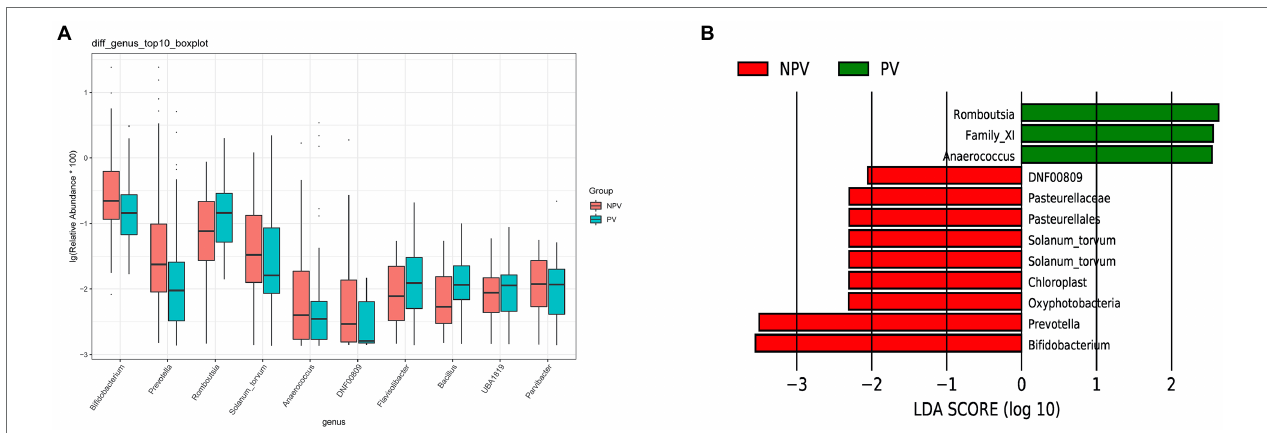
FIGURE 6 | Differences in the vaginal microbiota between pregnant and non-pregnant groups. (A) Boxplot of the top 10 genera in the differential genera between the two groups. (B) Linear discriminant analysis to explore potential genera in vagina contributing to intergroup differentiation. The green bar indicates the genera contributing to the pregnant group, while the red bars indicate the genera contributing to the non-pregnant